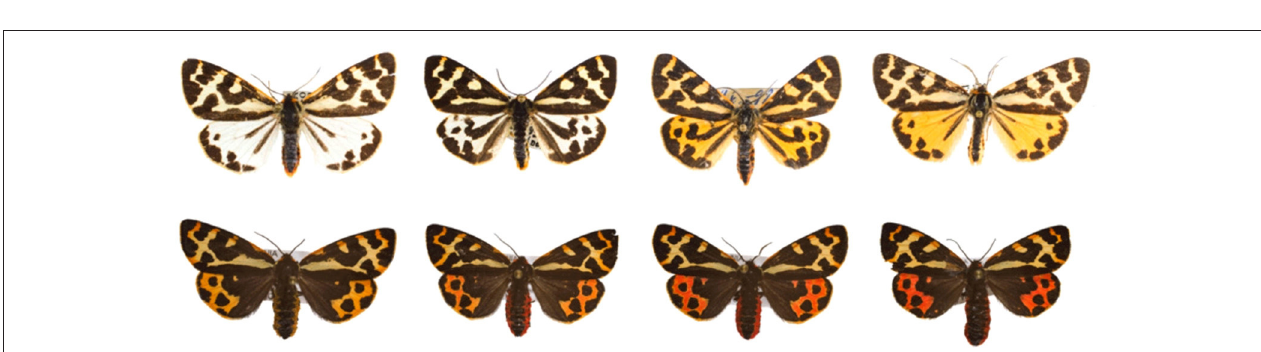
FIGURE 8 | The different morphs of the wood tiger moth in Europe. The upper row shows polymorphic color variation in males, whereas the bottom row showcases the continuous variation observed in females. Reproduced with permission from Nokelainen (2013). Photos: S. Waldron.